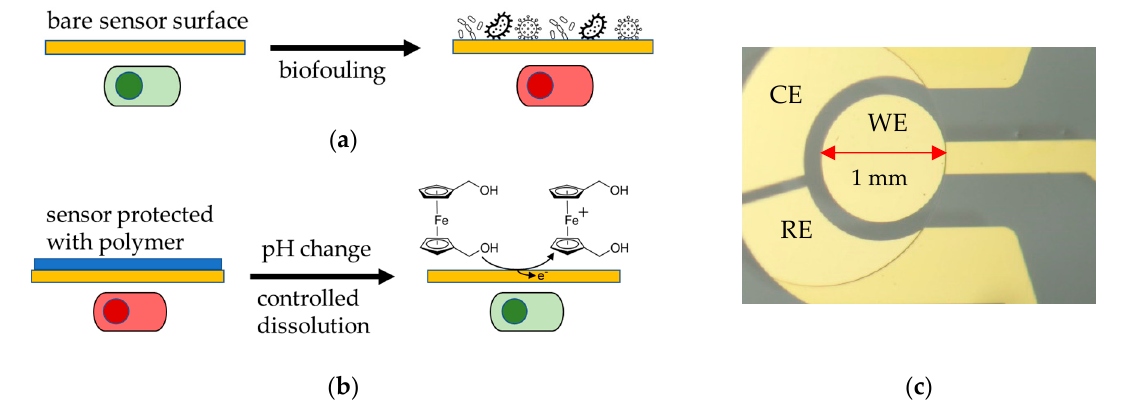
Figure 1. ( a ) Biofouling of an unprotected bare sensor surface hinders sensing due to non-specific adsorption on the surface (green: functional sensor, red: unfunctional sensor). ( b ) Experimental principle of this study: An EUDRAGIT ® polymer layer protects the Au electrode surface from biofouling; its dissolution is triggered by a change in pH. The dissolution process is continuously monitored electrochemically by biasing the electrode and observing an increase in Faradaic current as the surface becomes accessible for the oxidation of a Fc(MeOH) 2 redox probe. ( c ) Micrograph of a gold working electrode (WE) with 1 mm diameter (on-chip quasi reference and counter electrode were not used and kept electrically floating during all experiments). The leading wire on the right side is insulated by an SU-8 resin.